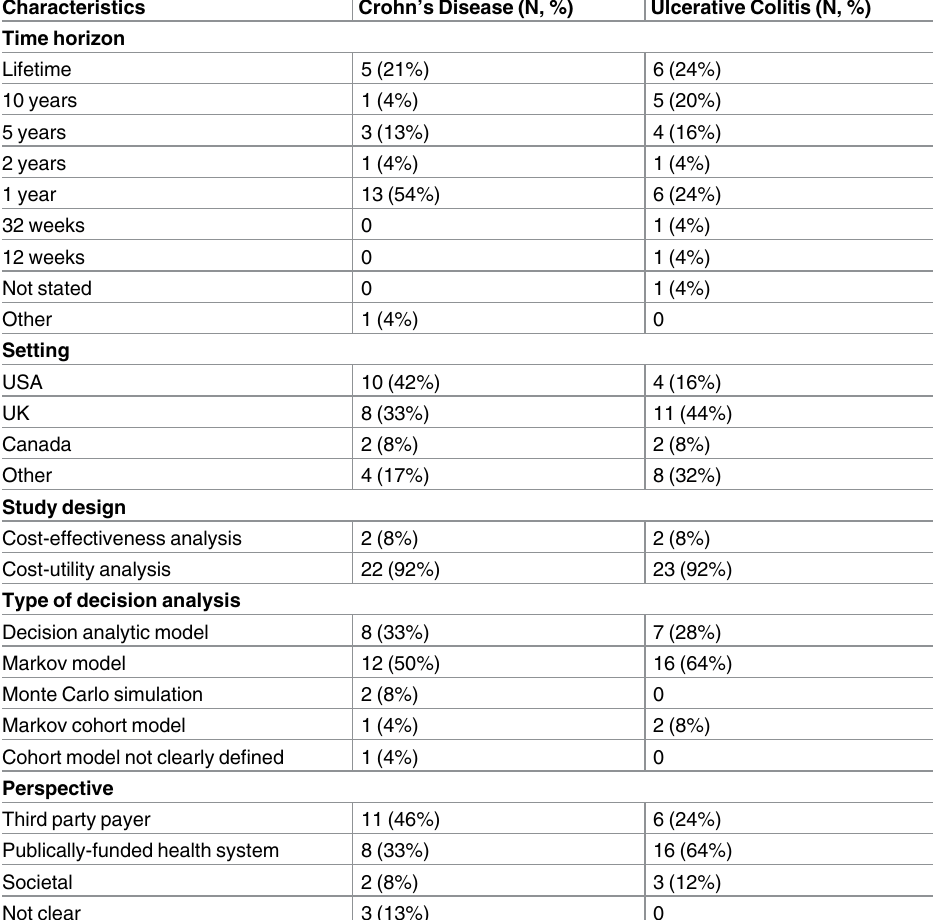
Table 1. Key characteristics of published economic evaluations in Crohn’s disease and ulcerative colitis.